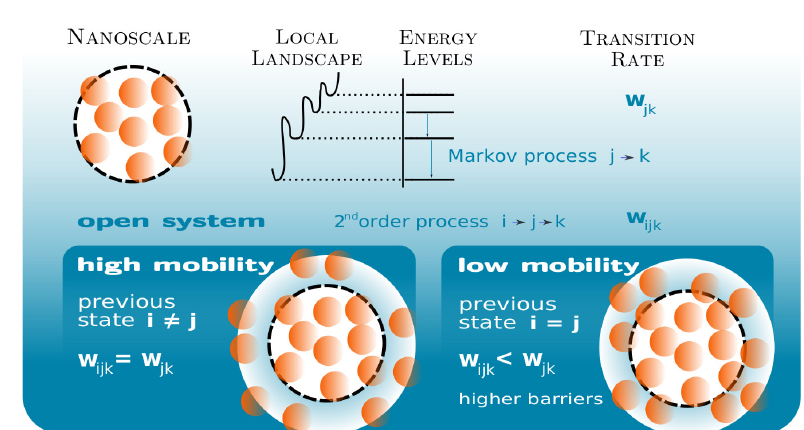
Figure 1. Conceptual diagram of the non-Markovian model of the dynamics of a glass-forming material composed by a set of equivalent clusters. The local energy landscape of the cluster controls its dynamics through the energy levels and the potential barriers between them. The state of the system is given by the fraction d j of clusters at every energy level j. The evolution of the independent or closed cluster (upper panel) is determined by a Markov process with transition probability w jk . The evolution of the open system (lower panel) is more complex: due to the interaction with its environment, the open cluster can have the high mobility of the independent cluster (lower panel, left) or a lower mobility (lower panel, right), maintaining the same energy levels but with higher potential barriers between them. A cluster whose state has changed recently is considered to have high mobility and is considered to have low mobility if it has maintained the same state. The cluster evolution is then a non-Markovian